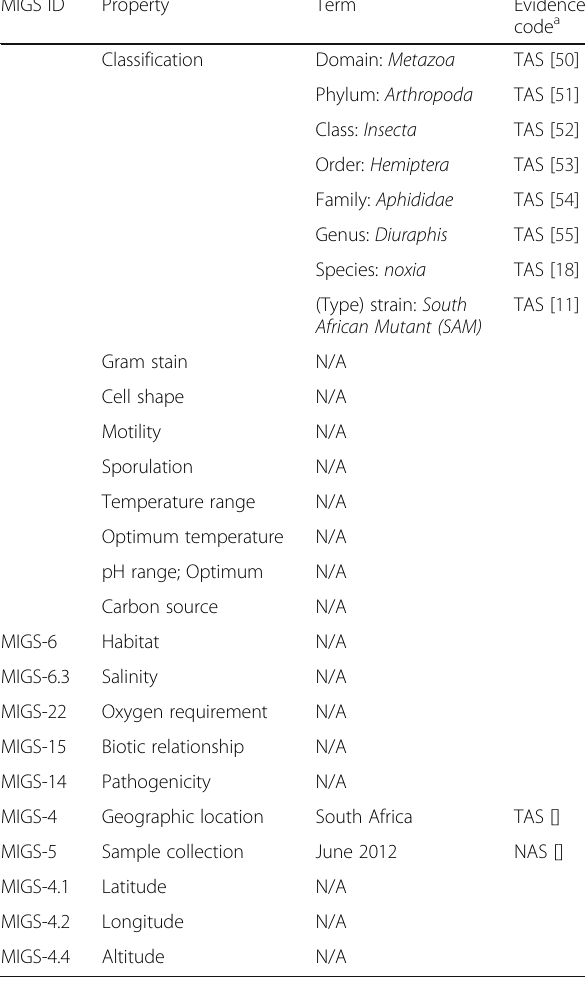
Table 1 Classification and general features of Diuraphis